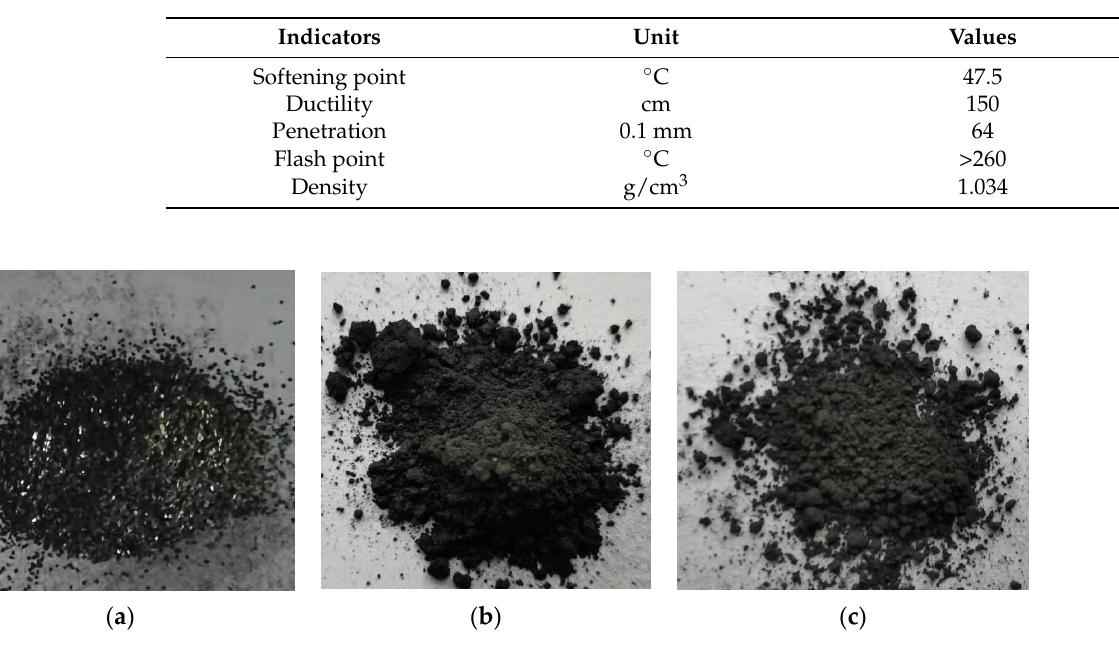
Figure 1. Carbon blacks: ( a ) CB ‐ 1, 270 μ m, ( b ) CB ‐ 2, 25 μ m, ( c ) CB ‐ 3, 2.6 μ m.